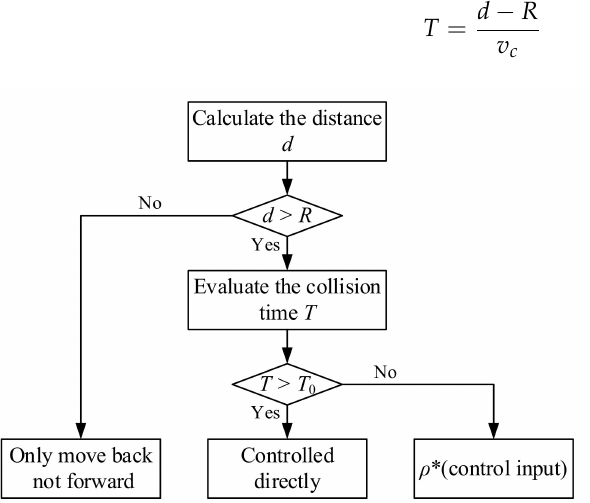
Figure 4. Collision avoidance